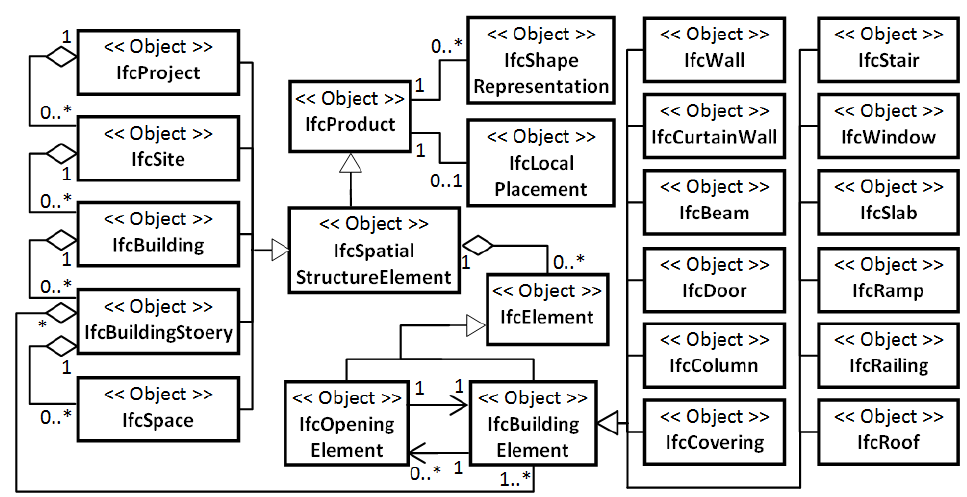
Figure 1. IFC building